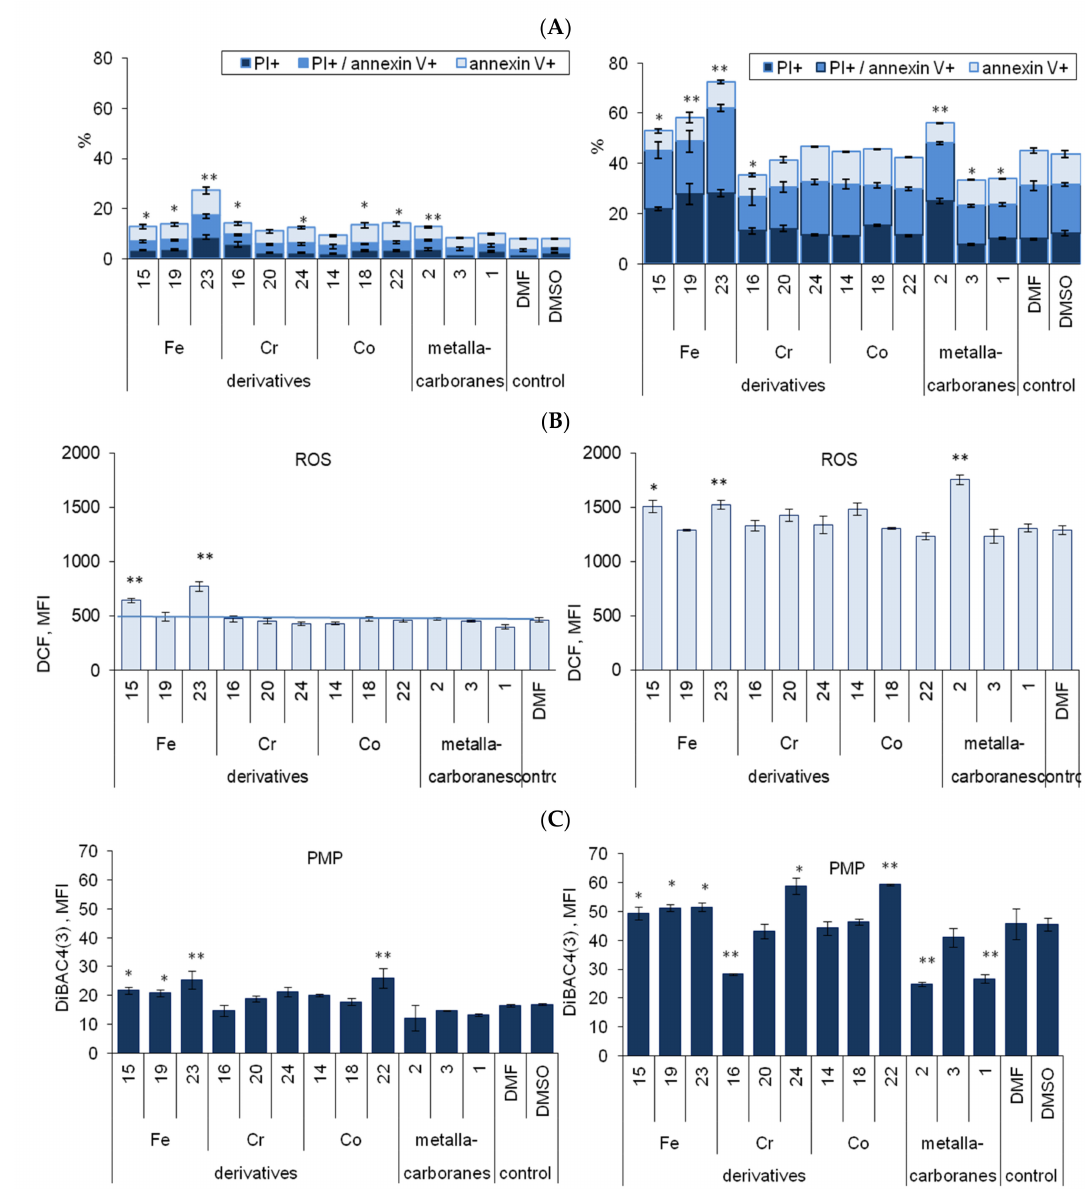
Figure 5. Effect of compounds 1 – 24 alone (40 µ M) and in combination with cisplatin (10 µ M) on the apoptosis and necrosis in A2780cis cells ( A ), ROS generation ( B ), and plasma membrane potential ( C ). N-dimethylformamide (DMF) or dimethyl sulfoxide (DMSO) (< 0.04%, not toxic) was used as the control. Data are the mean of three to six independent experiments ± SEM; * p < 0.05; ** p < 0.01, compound versus without compound, Student t-test with Bonferroni correction. ( A ) Data were expressed as cumulative percentage of apoptotic and necrotic cells at different stages: necrosis (PI+, annexin V − ), late (annexin V+/PI+), and early apoptosis (annexin V+/PI − ); p values for nonapoptotic cells are shown, a detailed statistical analysis for necrosis and apoptosis is in the Supplementary Materials, Figure S1. ( B ) ROS generation was assessed by using the DCF-DA assay and measured by flow cytometry, data are expressed as MFI, median intensity of DCF fluorescence. ( C ) Plasma membrane potential was measured as DiBAC4(3) median fluorescence intensity (MFI) in